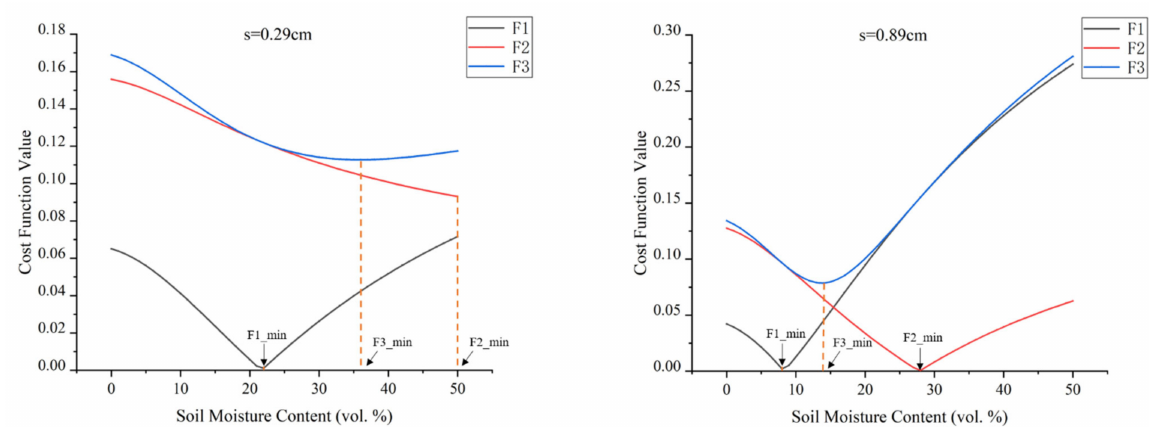
Figure 13. Values of three cost functions under different roughness